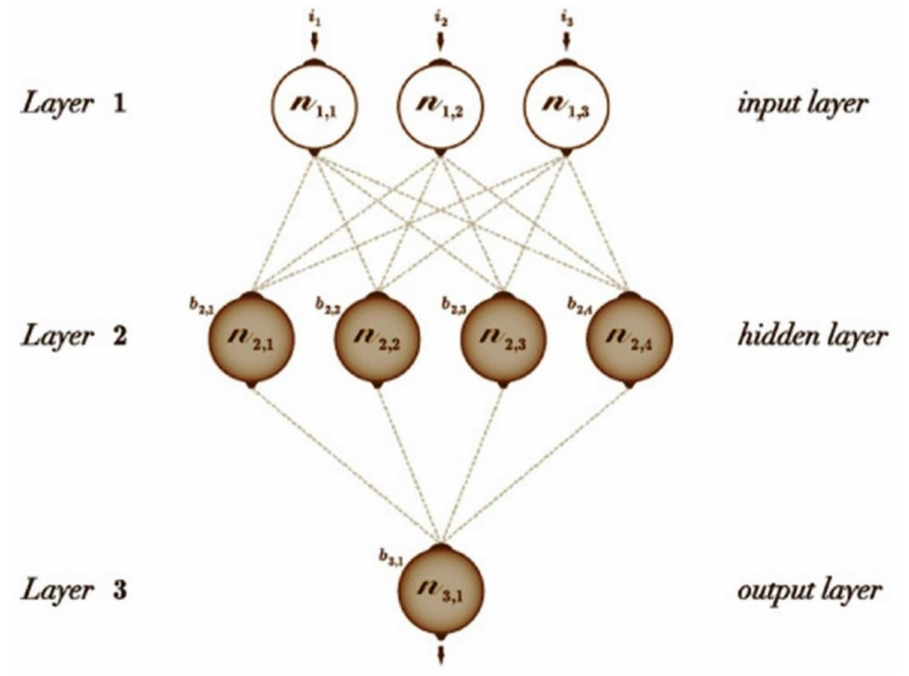
Figure 12. Typical structure of ANN. Reproduced from Reference [149] with permission. Copyright 2018,